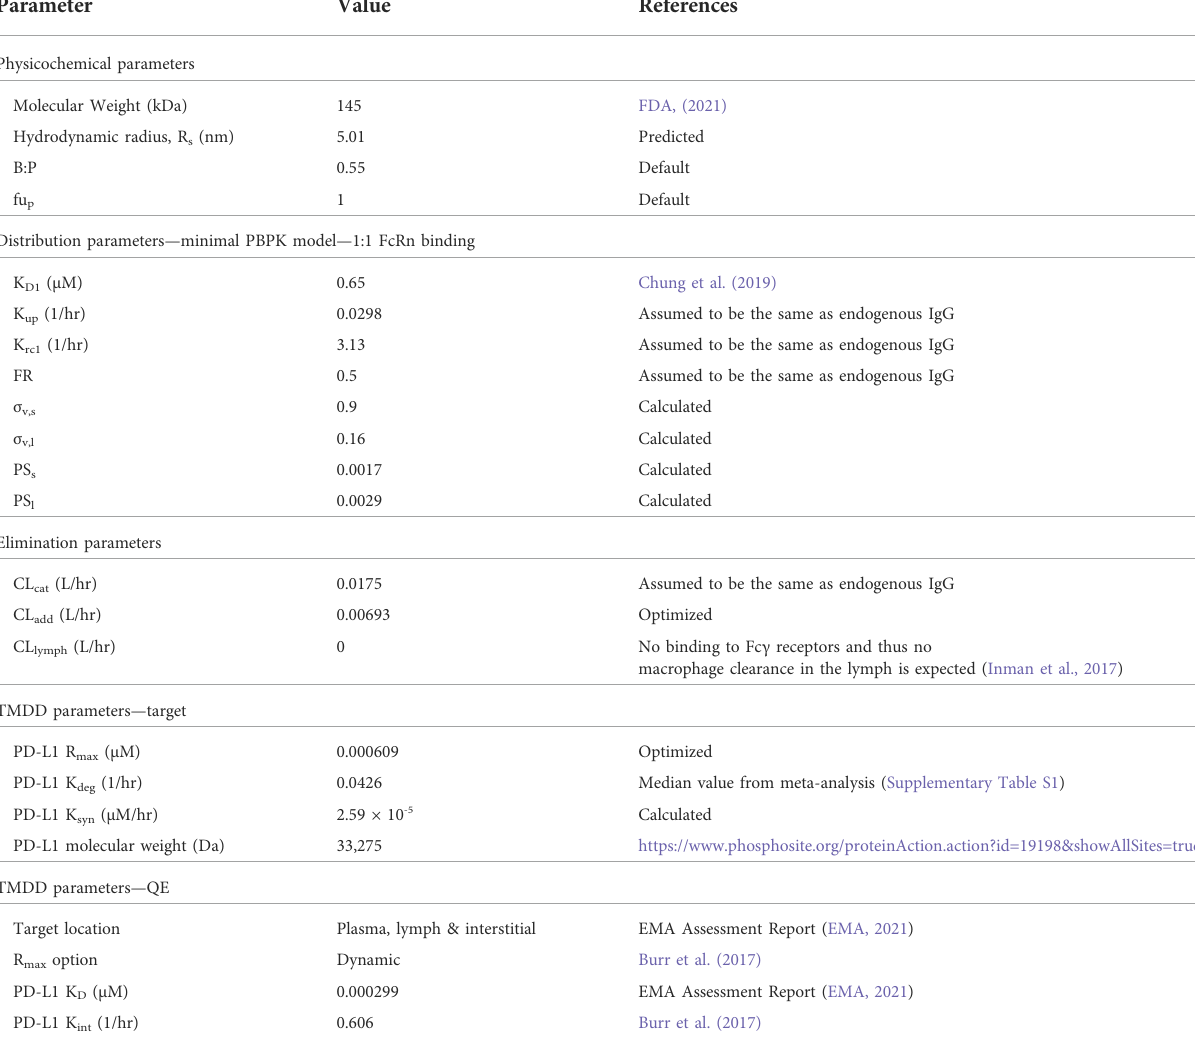
TABLE 1 Parameter values for atezolizumab PBPK